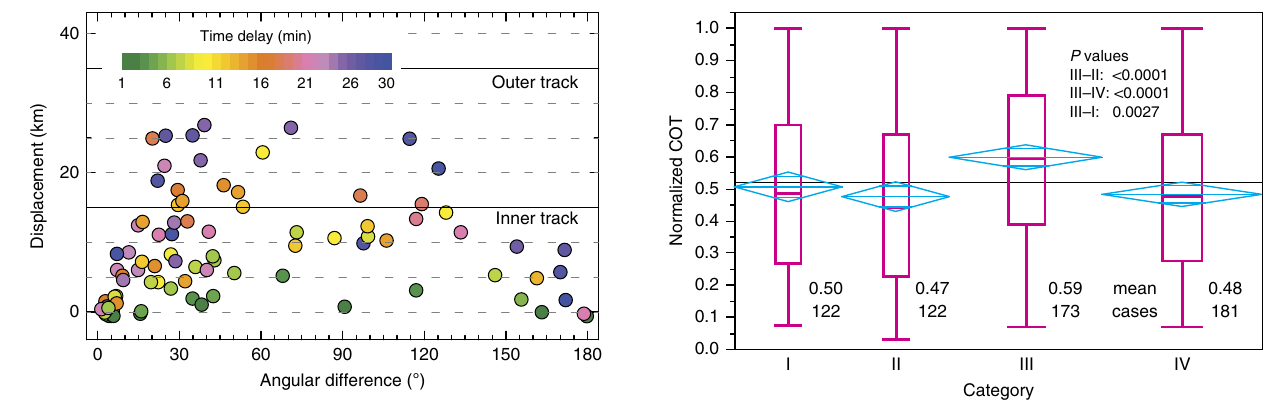
first calculate the wind vector component along the CALIPSO track to find point (3), then use the wind vector to calculate the origin of the air that CALIPSO would have observed at this new point (which is point (4) in the illustration). Given the CALIPSO/ flight track geometry, the lag time between the satellite and air- craft passing point (1) and the wind vector, this new point of origin may or may not be on the flight track aft of the aircraft. In any case, this iterative calculation would be necessary for each crossing.